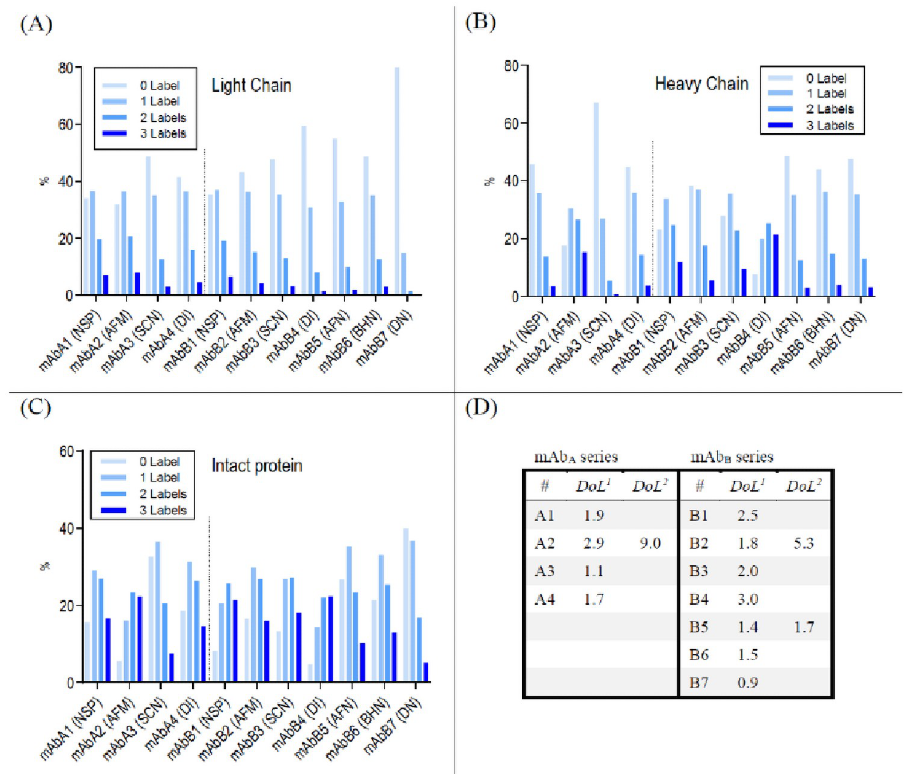
Fig 4. Labelling distribution of mAbA1-4 and mAbB1-7. (A): light chain; (B): heavy chain; (C) intact protein, according to Poisson distribution; (D): calculated degree of labelling (DoL). DoL 1 : based on labelling distribution determined by mass spectrometry analysis; DoL 2 : based on spectroscopic calculation for fluorescence labelled mAbs (Supplementary Information: S2 Formula). Label Code: NSP: N -succinimidyl propionate; AFM: Alexa Fluor 488-maleimide; SCN: Tm- p -SCN-Bz-DOTA; DI: direct iodination; AFN: Alexa Fluor 488-NHS; BHN: Bolton-Hunter- NHS; DN: DOTA-NHS.